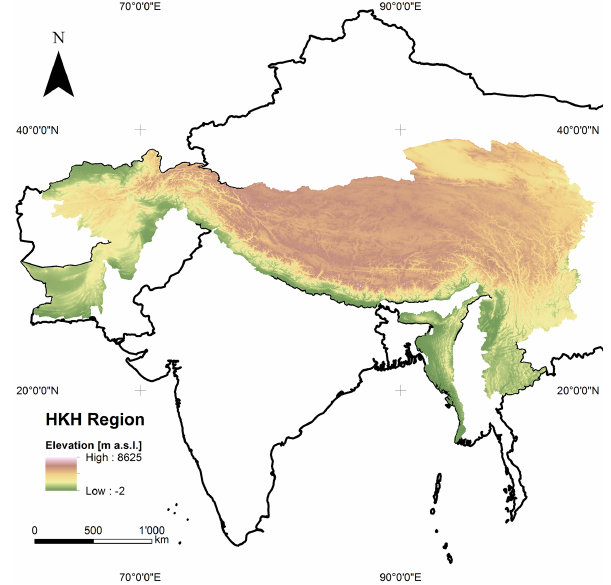
Figure 1. The HKH region as defined by ICIMOD which includes high mountains in Afghanistan, Bhutan, China, India, Myanmar, Nepal, and Pakistan. SRTM DEM version 4.1 from CGIAR at a spatial resolution of 90m (Jarvis et al., 2008) shown in the WGS84 coordinate